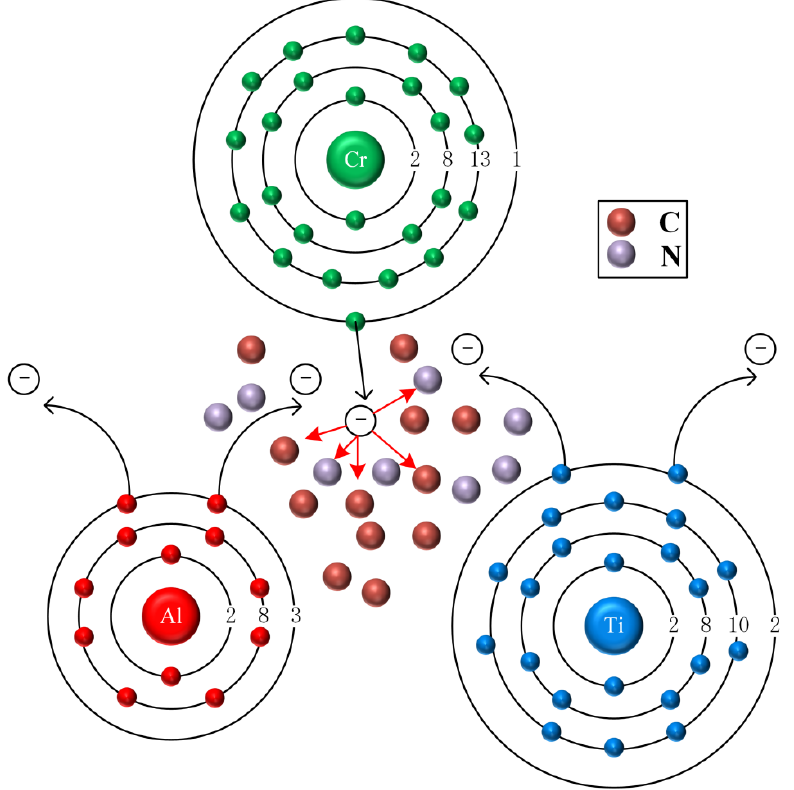
Figure 6. X-ray di ff raction pa tt erns of the 5th, 15th and 25th groups of AlSiTiN–AlCrN coatings. Figure 6. X-ray diffraction patterns of the 5th, 15th and 25th groups of AlSiTiN–AlCrN coatings.